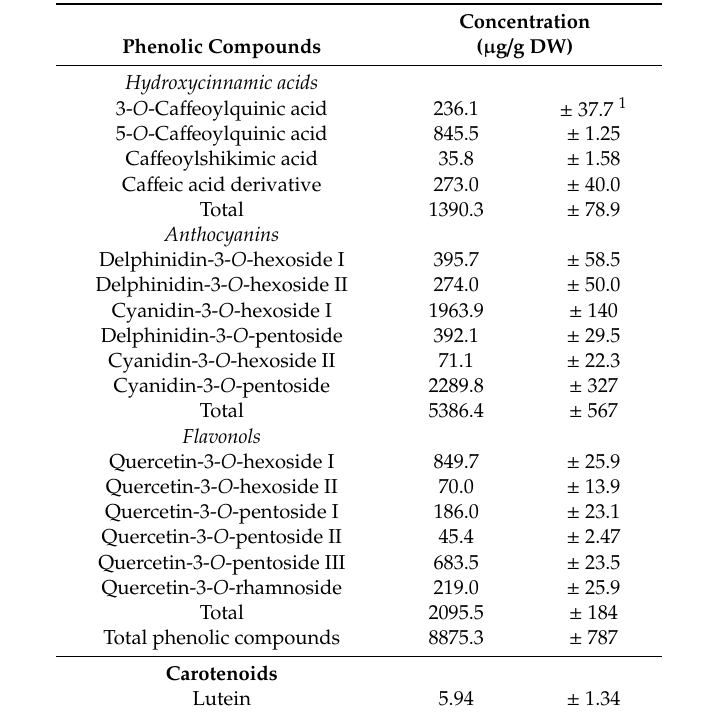
Table 3. Phenolic compounds and carotenoids quantified in Andean blueberry ( n =